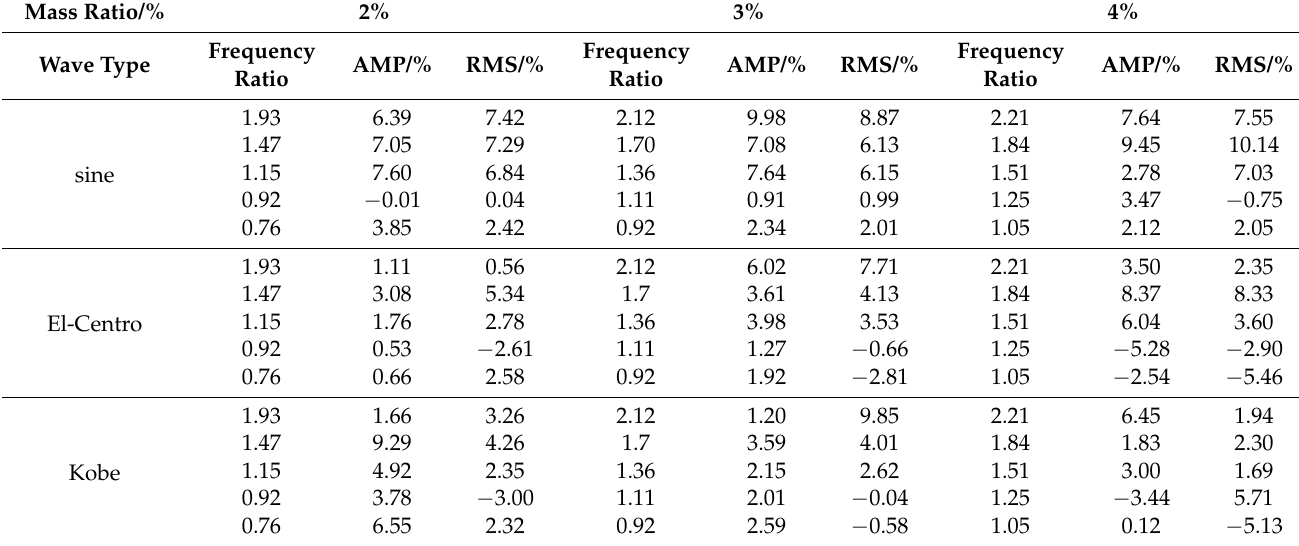
Table 4. Vibration damping